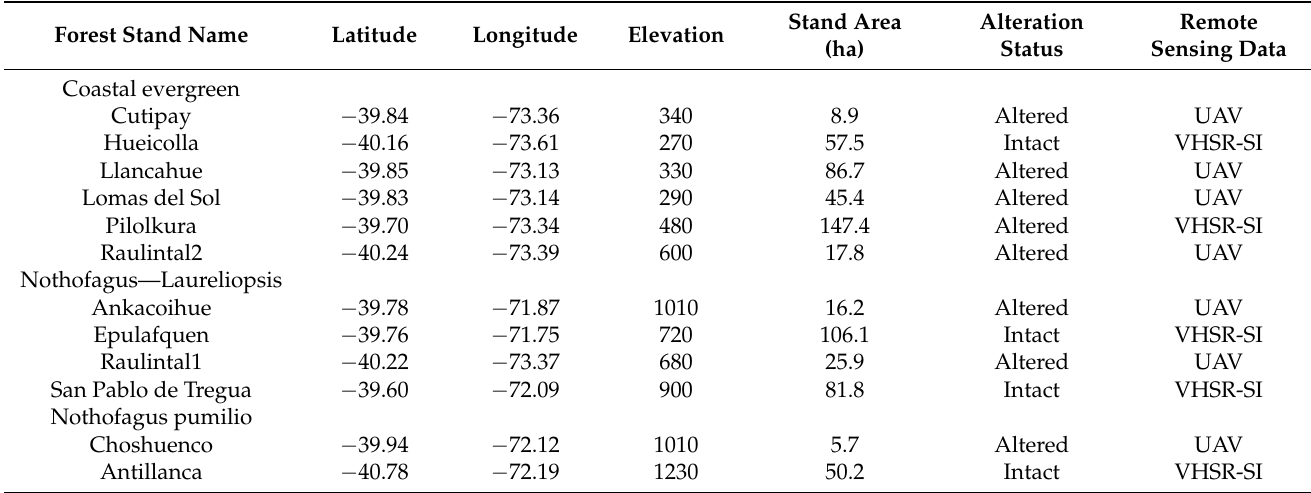
Table 1. Forest stand characteristics and remote-sensing data used in this study. UAV: unmanned aerial vehicle mosaic; VHSR-SI: very high spatial-resolution satellite imagery. Forest Stand